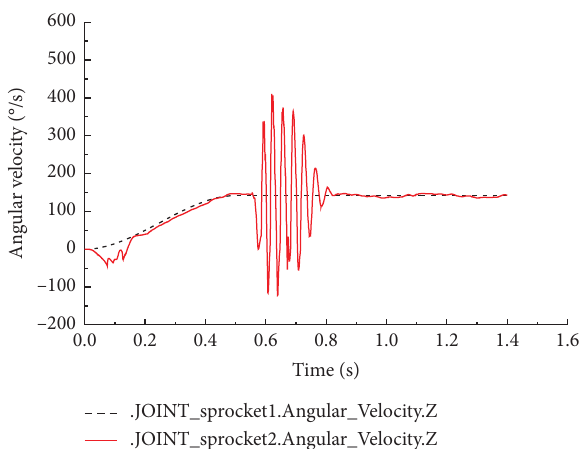
Figure 10: Sprocket rotational speed change curve.